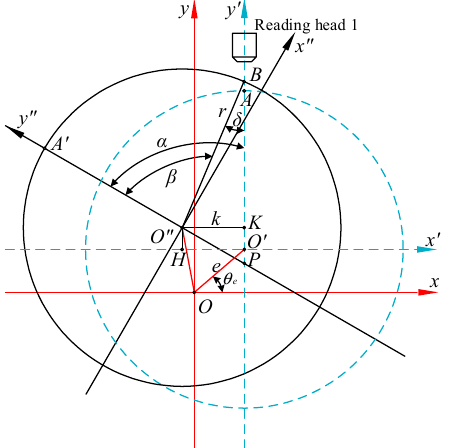
Figure 2. Schematic diagram of the eccentricity error of angle measurement with a single reading head.